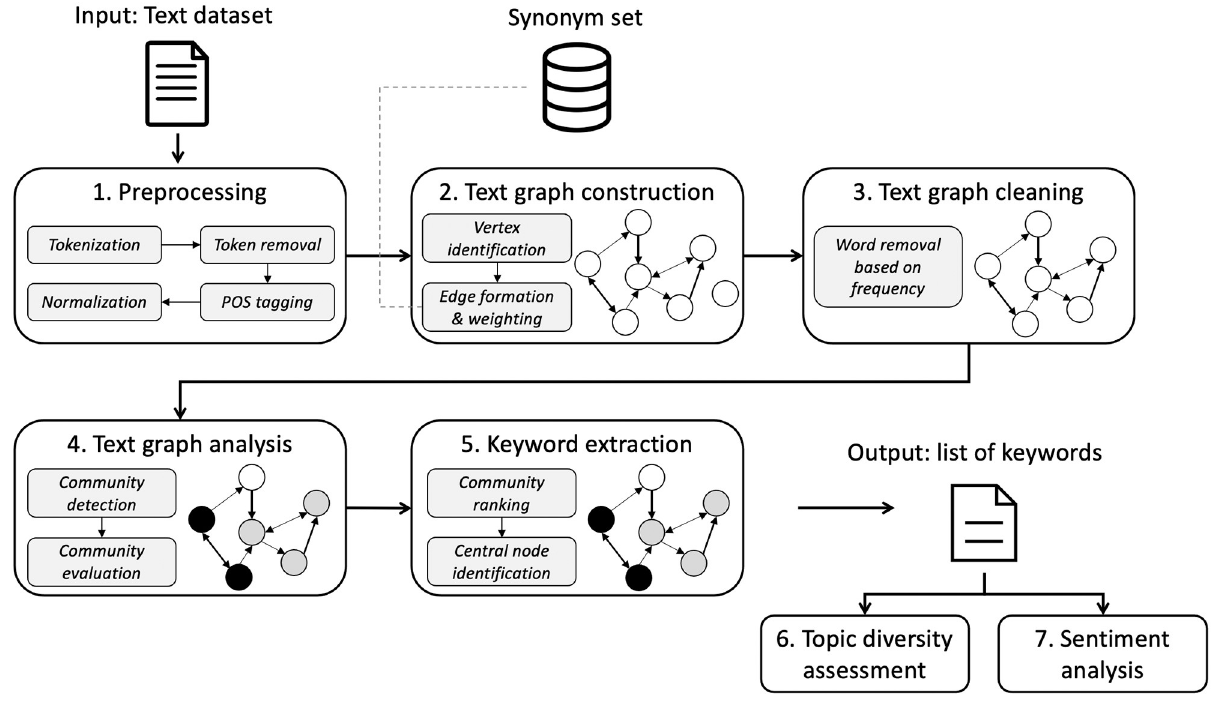
Fig 2. Proposed method main steps and